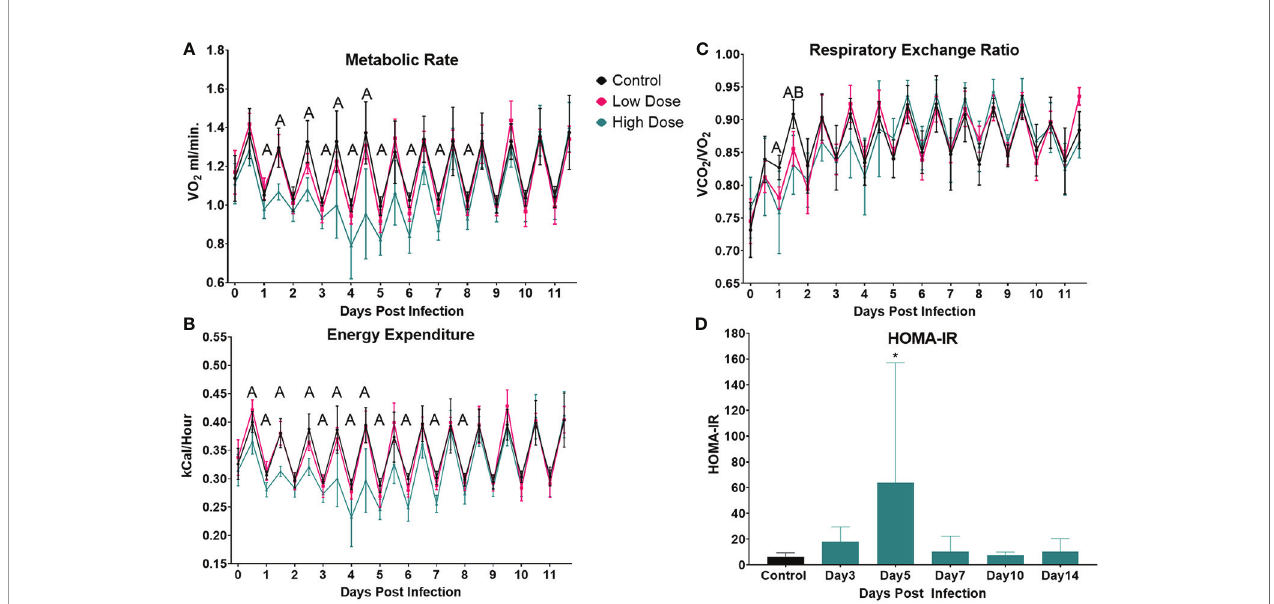
FIGURE 2 | Infection-induced changes to systemic metabolism. Analysis of change in (A) Metabolic rate (VO 2 ), (B) Energy Expenditure, or (C) Respiratory Exchange Ratio (VCO 2 /VO 2 ) over the 12-day experimental period. Each data point represents the average for a 12-h light/dark cycle. The Weir Equation was used to calculate EE (kcal/h = 60 × (0.003941 × V ̇ O 2 + 0.001106 × V ̇ CO 2 ), and an ANCOVA was utilized to adjust EE for bodyweight. Signi fi cance was assessed using one-way ANOVA followed by a Dunnett Test for multiple comparison. Data are represented as mean ± SD. A indicates a signi fi cant between High Dose - Control and B indicates a difference between Low Dose - Control at a p =/< 0.05. Control (n = 6), High Dose (n = 5), Low Dose (n = 5). (D) The HOMA-IR was used to determine